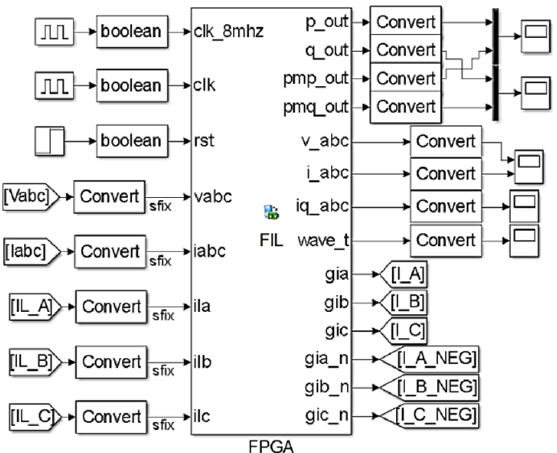
Figure 15. Field-programmable gate array (FPGA)-in-the-loop (smart meter) simulation block.